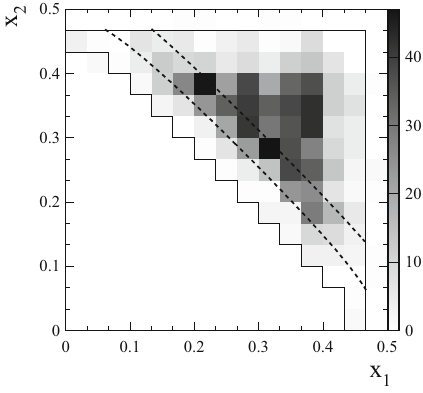
Fig. 5 The x 1 versus x 2 distribution for selected data events from the √ s = 1 . 63 − 1 . 68 GeV. The solid polygon indicate the Dalitz interval plotareausedinthefit.Theareabetweenthedashedcurvescorresponds to the condition 0 . 68 < M π + π − < 0 . 88 GeV